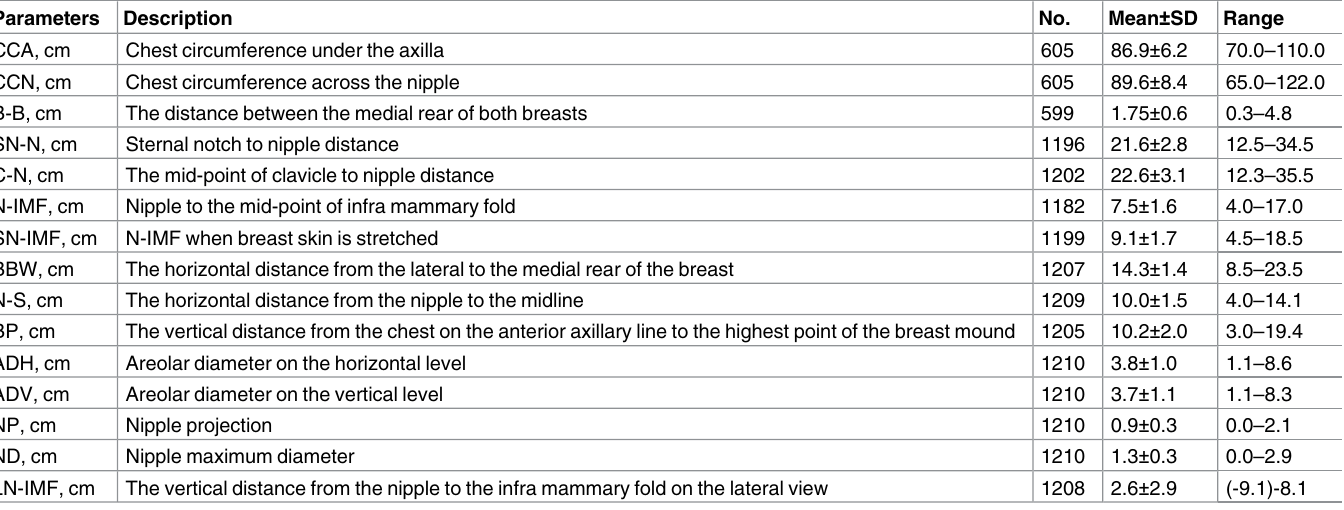
Table 2. Breastmeasurement methodology and data for 605 patients.